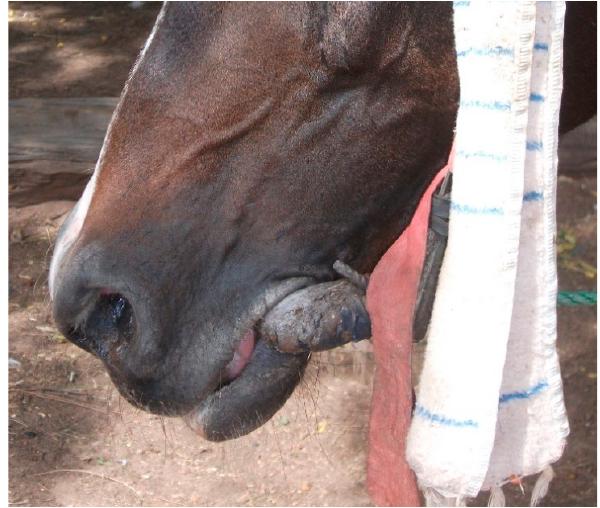
Figure 7. Locally produced bit in Senegal with excessively thick mouth-piece inhibiting mouth closure.